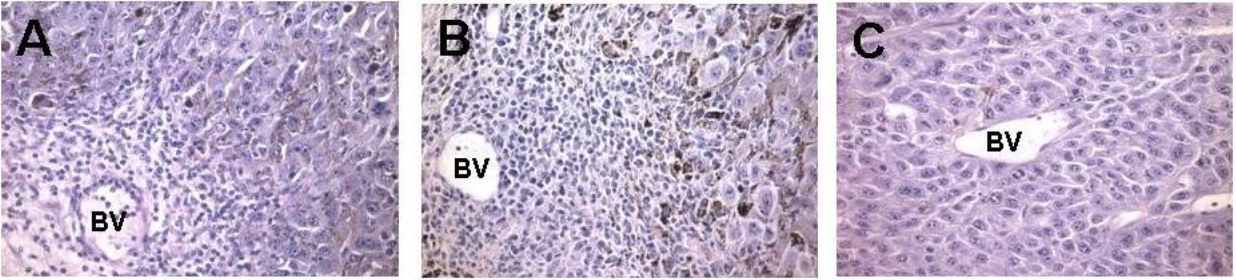
Figure 3. In vivo effect of injection of the  -gal glycolipids into B16 melanoma. Lesions reaching subcutaneous size of ~5 mm received one injection of  -gal glycolipids and were resected at different time points for histological analysis. ( A ) On day 2 post injection, mononuclear cells migrating from blood vessels (BV) are detected already; ( B ) On day 7 post injection, the infiltration is more extensive as indicated by the number of mononuclear cells migrating from blood vessels into the tumor; and ( C ) On day 7 post PBS injection, control tumors displayed no infiltration of mononuclear cells